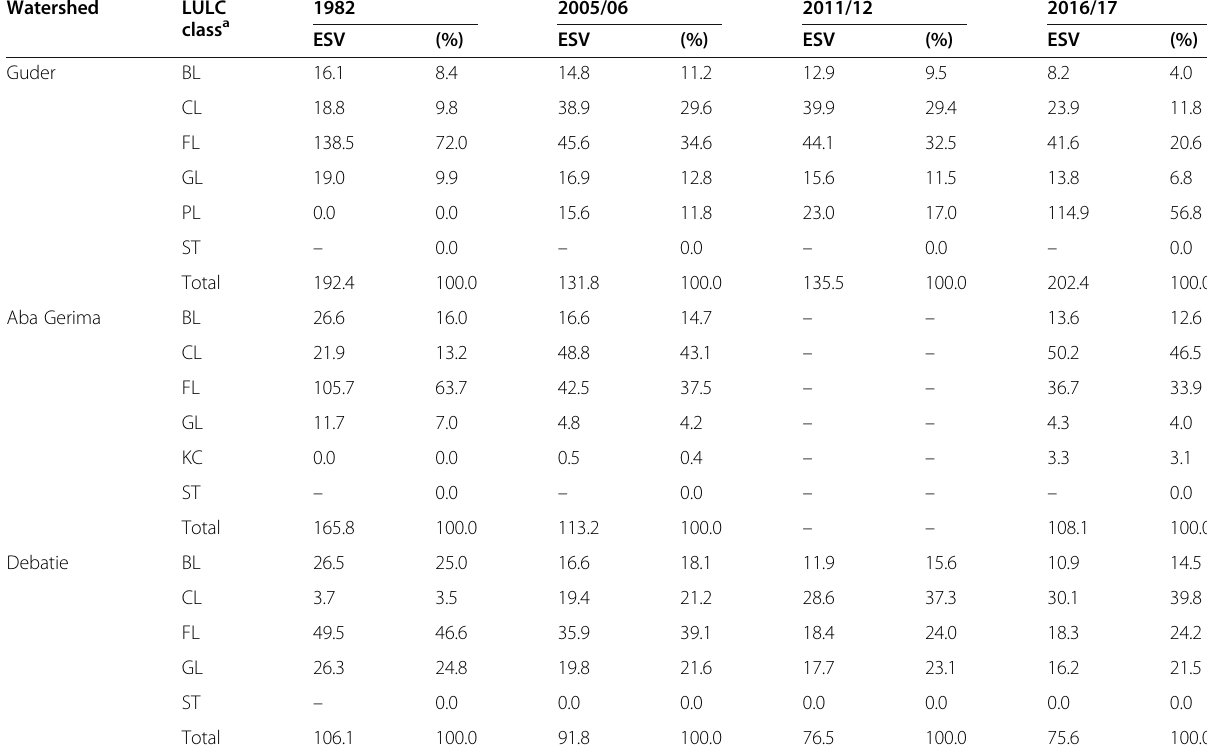
Table 3 Effect of changes in land-use/land-cover (LULC) on the total ecosystem service value (ESV; US$ [thousands], %) in Guder, Aba Gerima, and Debatie watersheds, Ethiopia. LULC abbreviations as defined in Table TS2 Watershed